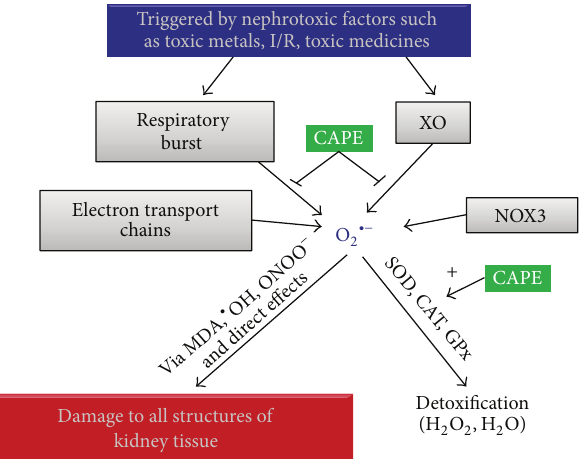
Figure 3: Proposed mechanism for the relationship between oxida- tive stress and the protective effect of CAPE on kidney. Abbre- viations: CAPE: caffeic acid phenethyl ester, CAT: catalase, GPx: glutathione peroxidase, H 2 O: water, H 2 O 2 : hydrogen peroxide, I/R: ischemia/reperfusion, MDA: malondialdehyde, NOX3: NADPH oxidase 3, O 2∙− : superoxide anion radical, ∙ OH: hydroxyl radical, ONOO − : peroxynitrite, SOD: superoxide dismutase, XO: xanthine